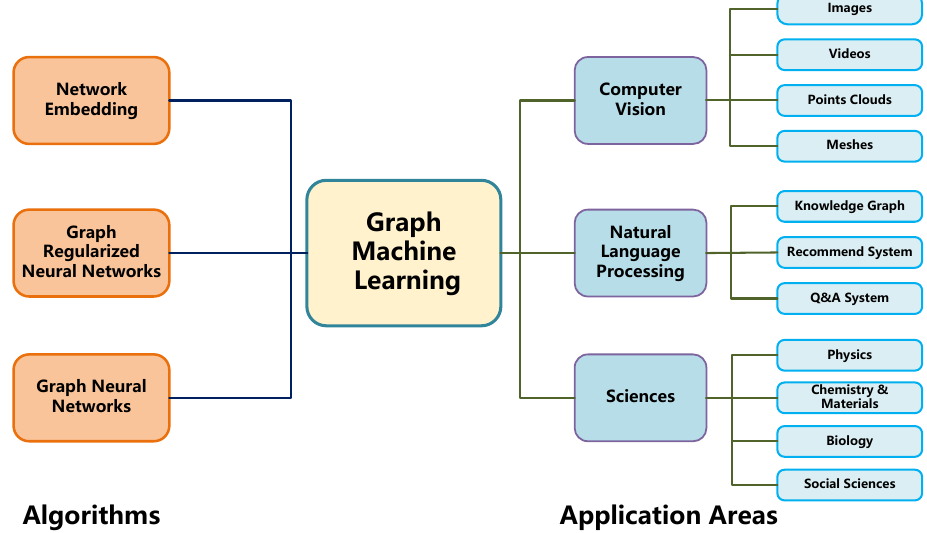
Figure 5. An illustration of graph machine